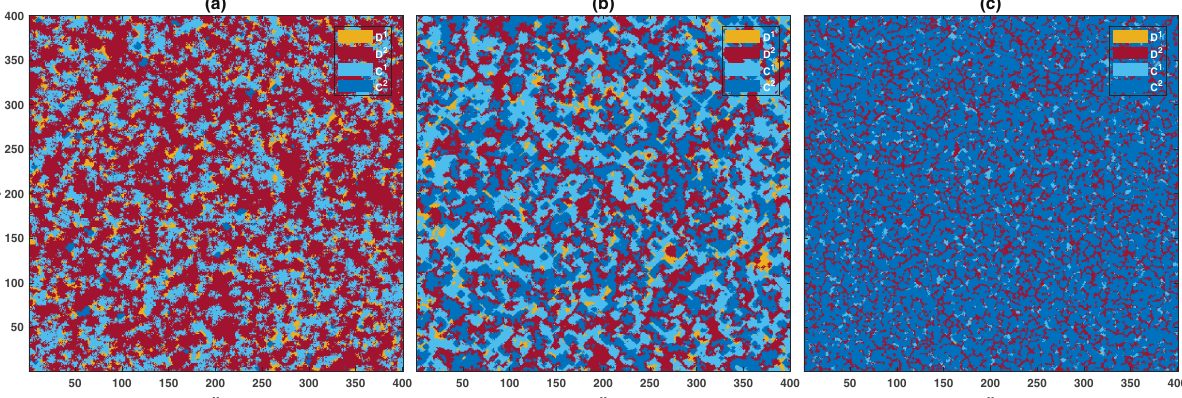
Fig. 5 Snapshots of the population in the stationary state for different parameter values. Different strategies are color codded (legend). In ( a ,) r 1 = 1.7, r 2 = 1.7, in ( b ,) r 1 = 3.5 and r 2 = 3.5, and in c , r 1 = 3, and r 2 = 1.8. In all the cases c g = 0.6. For small enhancement factors ( a ), the red queen dynamics in which cooperators only in the costly institute survive in large numbers occur. For larger enhancement factors ( b ), the black queen dynamics in which cooperators in both institutions survive and help each other suppress defection occur. By increasing the enhancement factors ( c ), non-costly cooperators dominate. However, a small frequency of costly cooperators survives and purge the population from defectors by moving along the bands of non-costly defectors. Here, individuals reproduce with a probability proportional to the exponential of their payoff with a selection parameter equal to β = 5. The population resides on a 400 × 400 square lattice with von Neumann connectivity and periodic boundaries. Parameter values: g = 5 and ν = 10 − 3